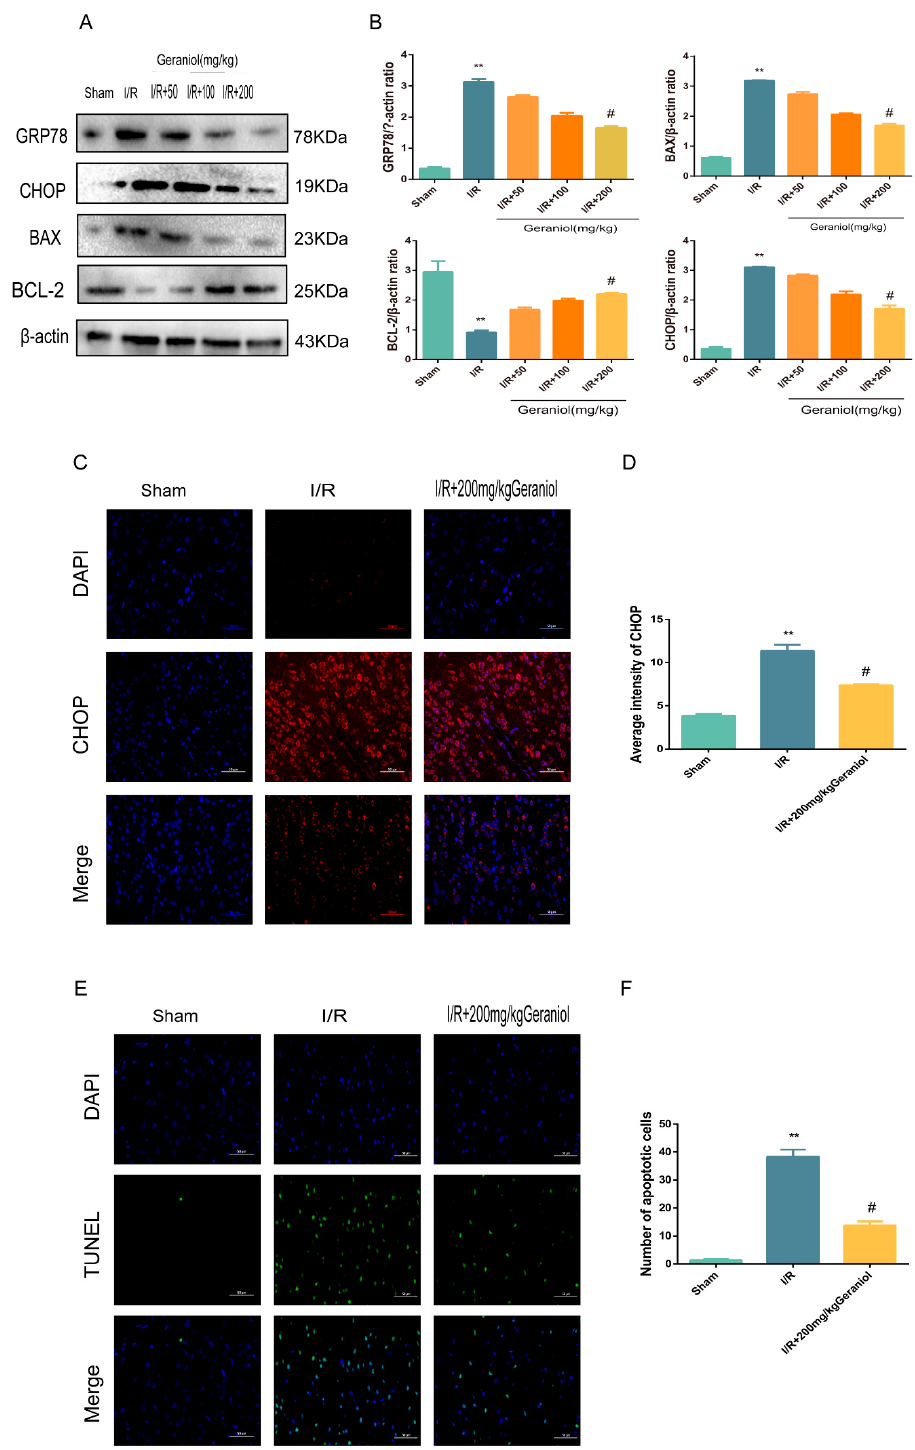
Figure 3. Geraniol reduces ischemia–reperfusion (I/R)-induced endoplasmic reticulum stress and cell apoptosis. ( A , B ) Western blot analysis of GRP78, BAX, BCL-2, and CHOP expression in the cortex ( n = 6). ( C , D ) Immunofluorescence staining of CHOP in the cortex. Representative images were acquired under 400 × magnification, scale bars = 50 µ m. ( E , F ) Apoptosis in the cortex detected via TUNEL assays ( n = 3). Representative images were acquired under 400 × magnification, scale bars = 50 µ m. ** p < 0.01 I/R group vs. sham group, # p < 0.01 I/R+200 mg/kg geraniol group vs. I/R